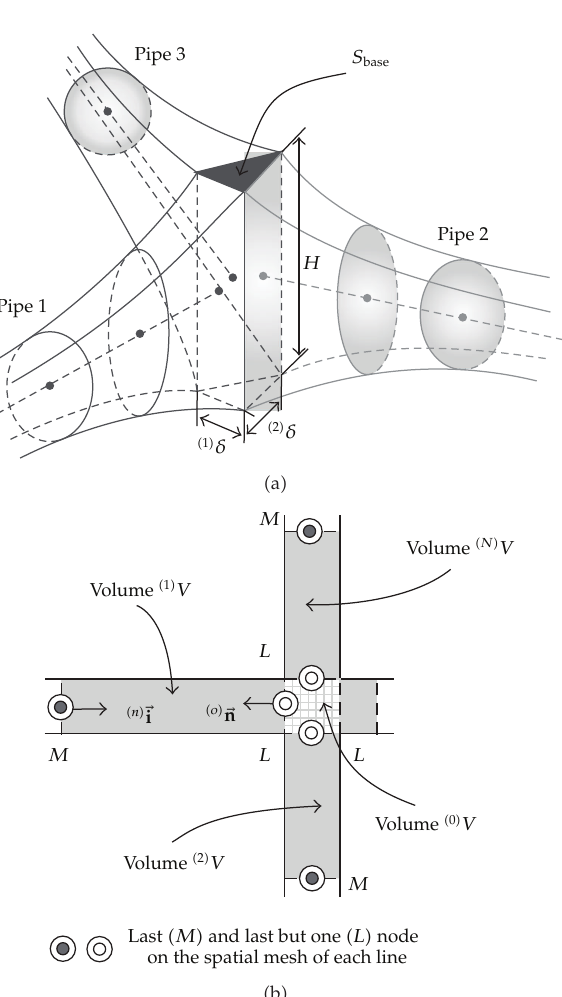
Figure 2: A Schematic of a pipeline junction: (cid:5) a (cid:6) 3D drawing; (cid:5) b (cid:6) plain